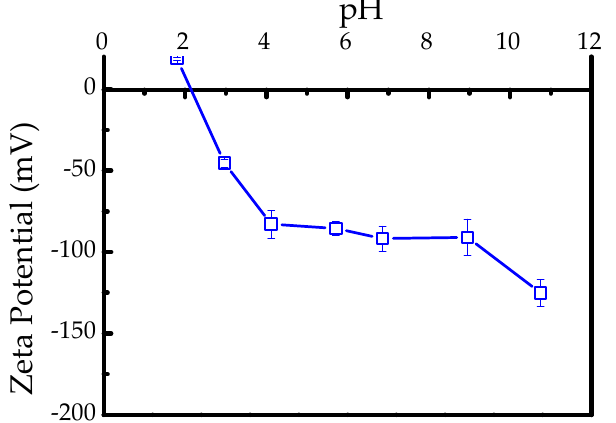
Figure 7. Zeta potential of UBC at different pH.